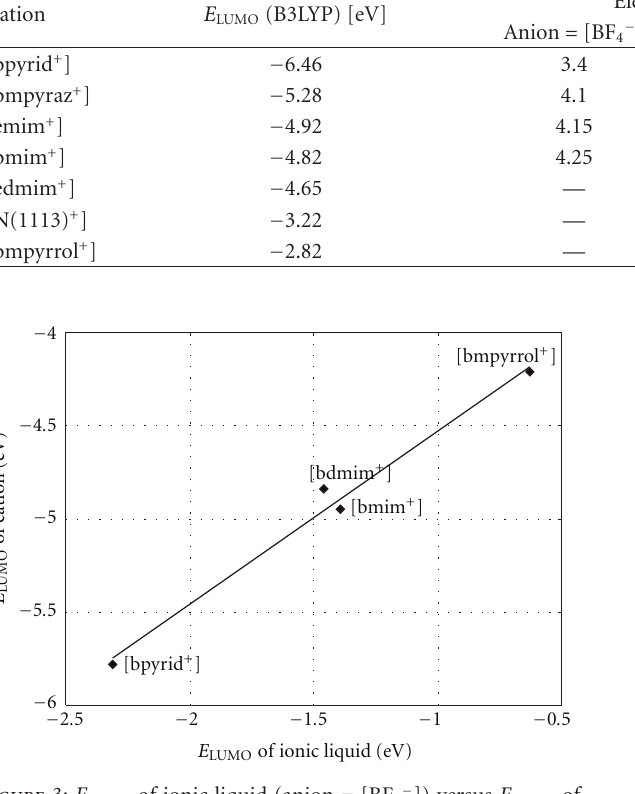
Figure 3: E LUMO of ionic liquid (anion = [BF 4 − ]) versus E LUMO of cation (calculated at PM3 level). The correlation coe ffi cient is 0.99. Figure 4: Plot of calculated E